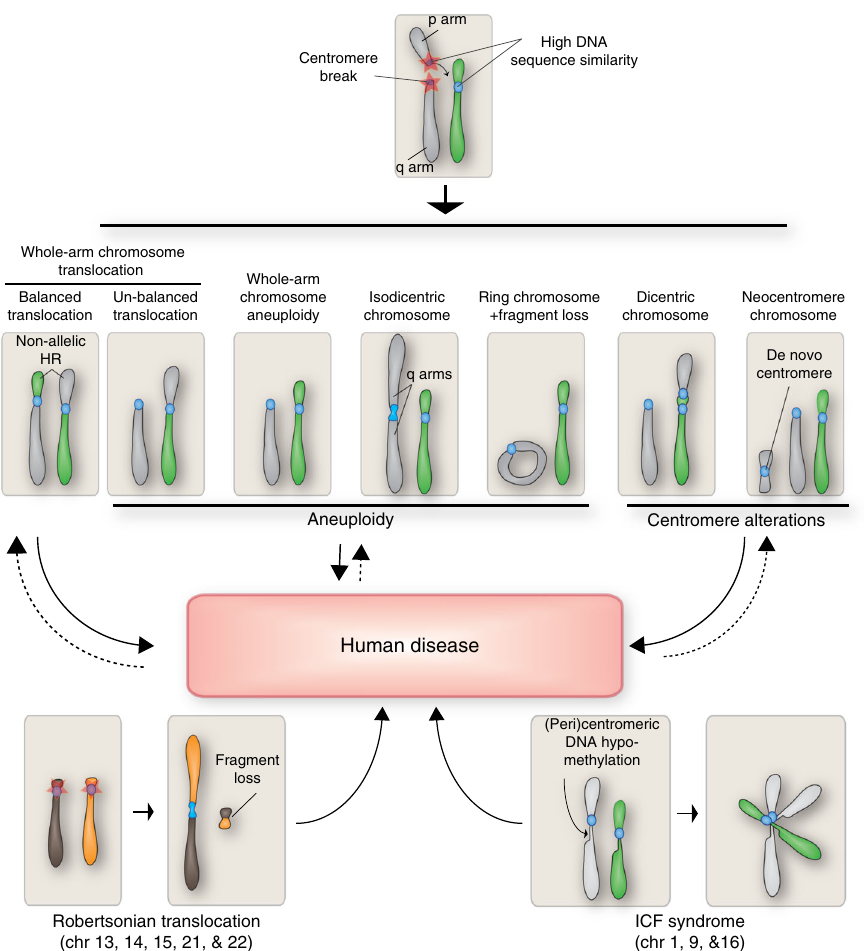
Fig. 1 Centromere breakage and human diseases. Representation of the genomic alterations deriving from centromere breaks such as aneuploidy, dicentric, and neocentromere chromosomes, Robertsonian translocations together with loss of methylation at (peri)centromere (typical of ICF syndrome), all known to contribute to human